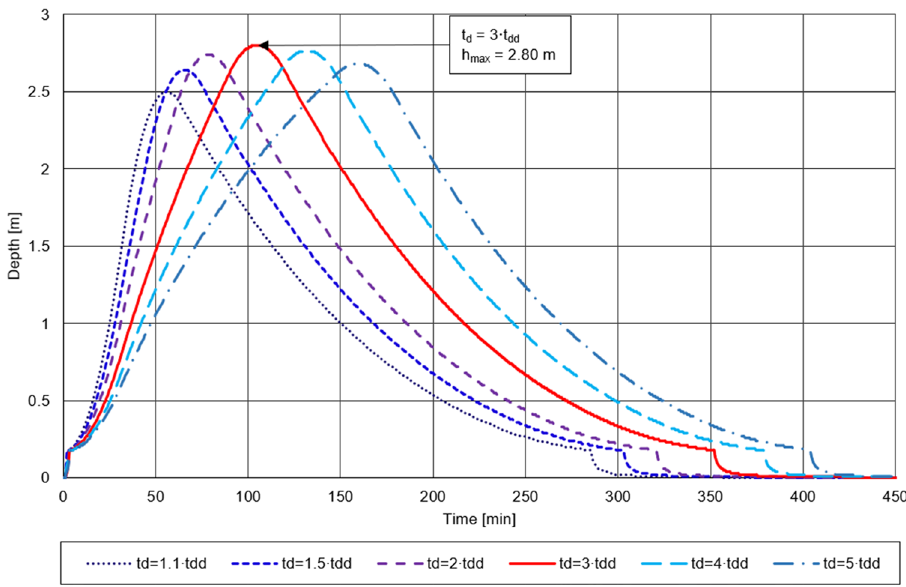
Fig. 3 The trial and error method applied for predict‑ ing the storm duration period, which gives the largest (required) depth of water in the tank h max